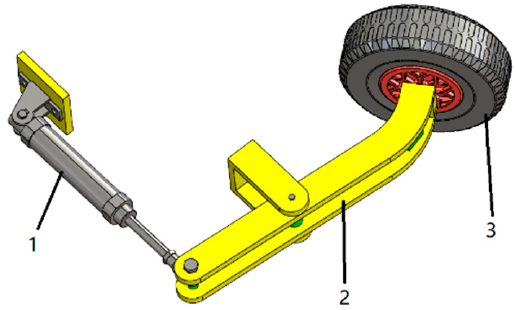
Figure 2. Clamping mechanism: 1—push rod cylinder; 2—connecting frame; 3—clamping wheel.